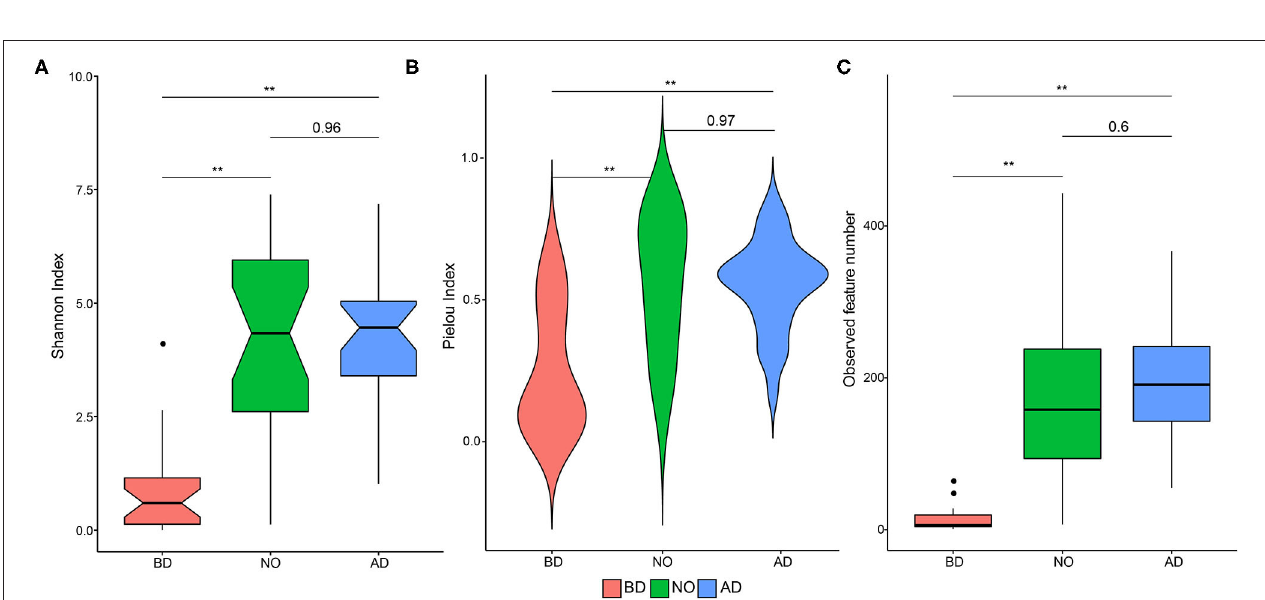
FIGURE 2 | Alpha-diversity plots in microbial community and the comparisons among the three groups (group BD, before delivery; group NO, neonatal oral; group AD, after delivery). (A) Shannon index, (B) Pielou index, (C) observed feature number. Notes, **means P value < 0.01.